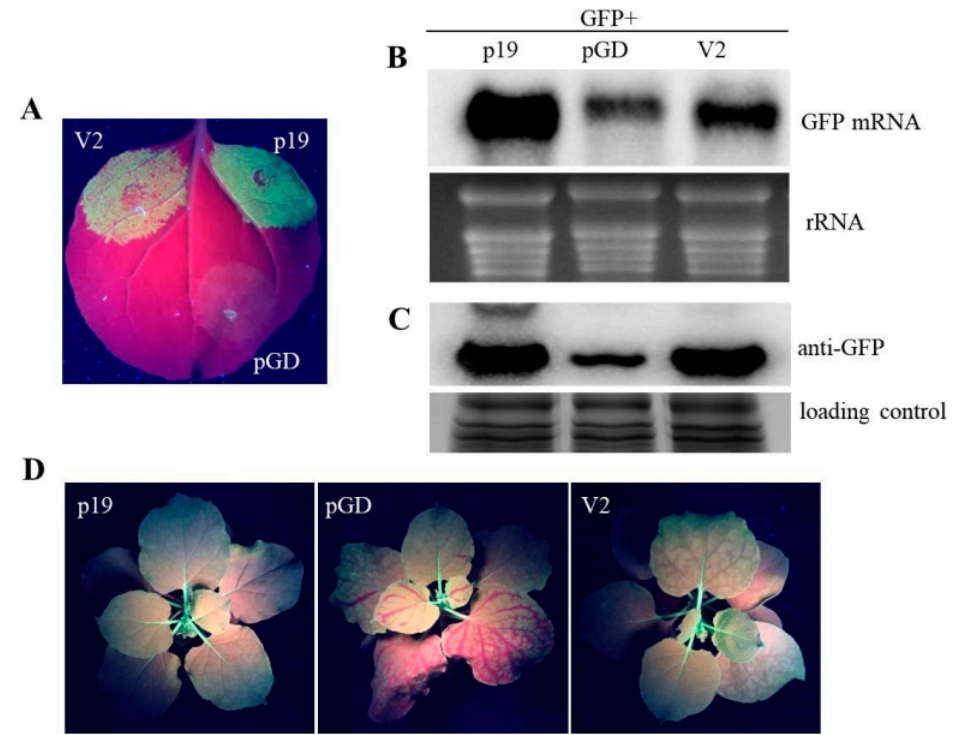
Figure 1. Suppression of posttranscriptional gene silencing by tobacco curly shoot virus (TbCSV) V2. ( A ) Suppression of gene silencing in wild-type Nicotiana benthamiana co-agroinfiltrated with Agrobacterium strain containing pGD-GFP and a train containing pGD-V2. Co-infiltration with pGD-GFP and pGD or pGD-p19 (expressing p19 protein encoded by TBSV) served as negative or positive control, respectively. Photographs were taken at 3 days post-agroinfiltration (dpa) under long-wavelength UV light. ( B ) Northern blot analysis of green fluorescent protein (GFP) mRNA extracted from the agroinfiltrated leaf regions. Blots were hybridized with probes specific for GFP mRNA. Ethidium-bromide-stained rRNA was used as an RNA loading control. ( C ) Western blot analysis of the GFP protein accumulation in leaf patches with different treatment at 3 dpa. The Coomassie-blue-stained gel served as a loading control. ( D ) TbCSV V2 suppresses systemic GFP silencing triggered by GFP sense RNA. Representative images were taken at 20 dpa. The lower leaves of 16c line N. benthamiana were co-infiltrated with Agrobacterium strain containing pGD-GFP and a train containing the indicated construct, and the GFP fluorescence on the upper leaves were detected at 20